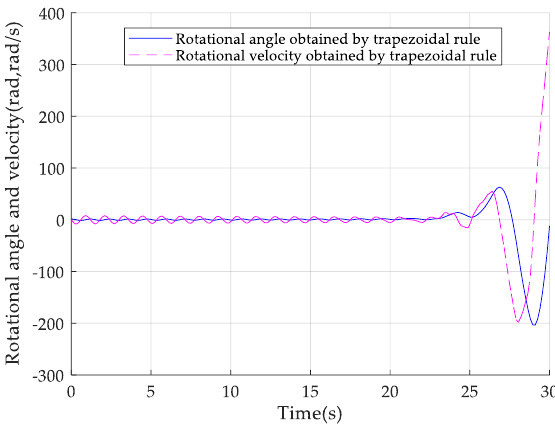
Figure 6. Responses of the pendulum using the trapezoidal rule with ∆ t = 0.15 s .